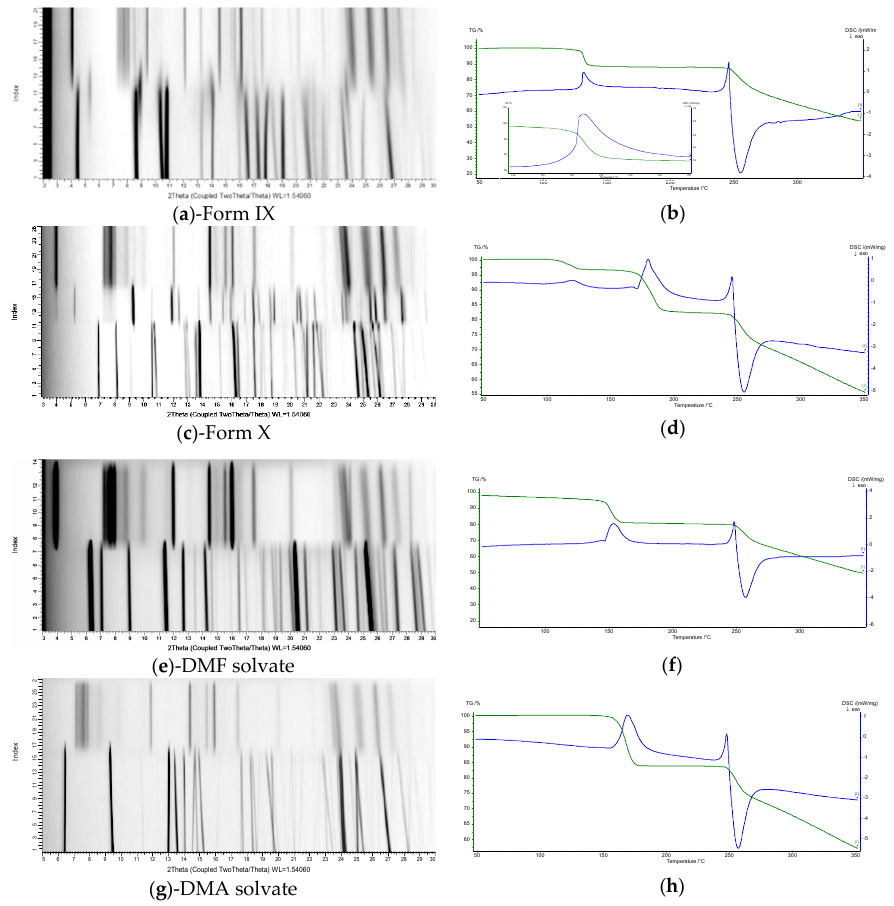
(narrow Bragg peaks) of all these stoichiometric solvates.